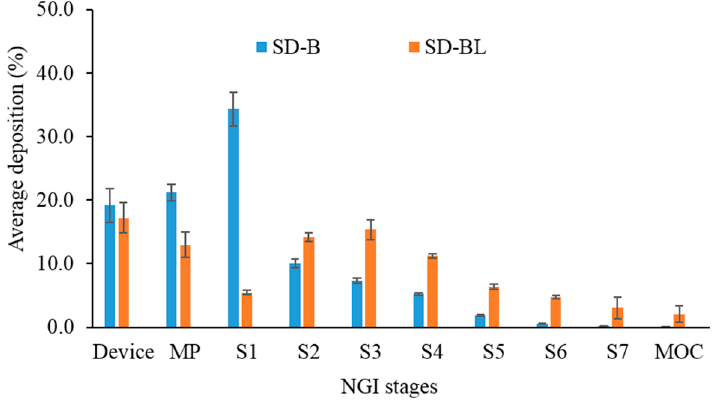
Figure 6. Deposition behaviour of spray-dried bedaquiline-only (SD-B) and bedaquiline with 20% w/w L -leucine (SD-BL) powders on different stages of next-generation impactor (NGI) (MP: mouthpiece, S1–S7 represent stages 1 to 7; MOC: micro-orifice collector, error bars represent standard deviations, n = 3).